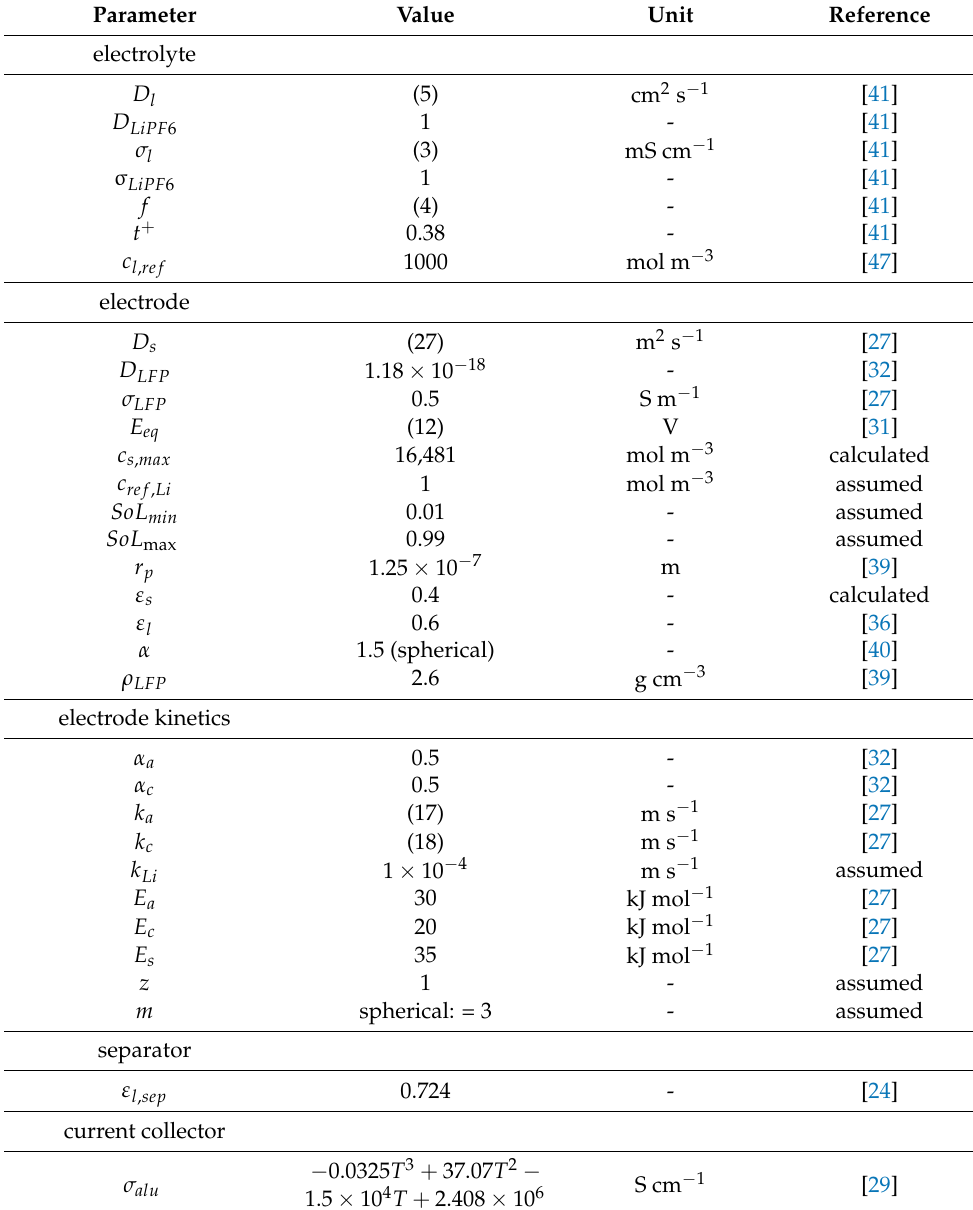
Table 3. Applied parameters for this